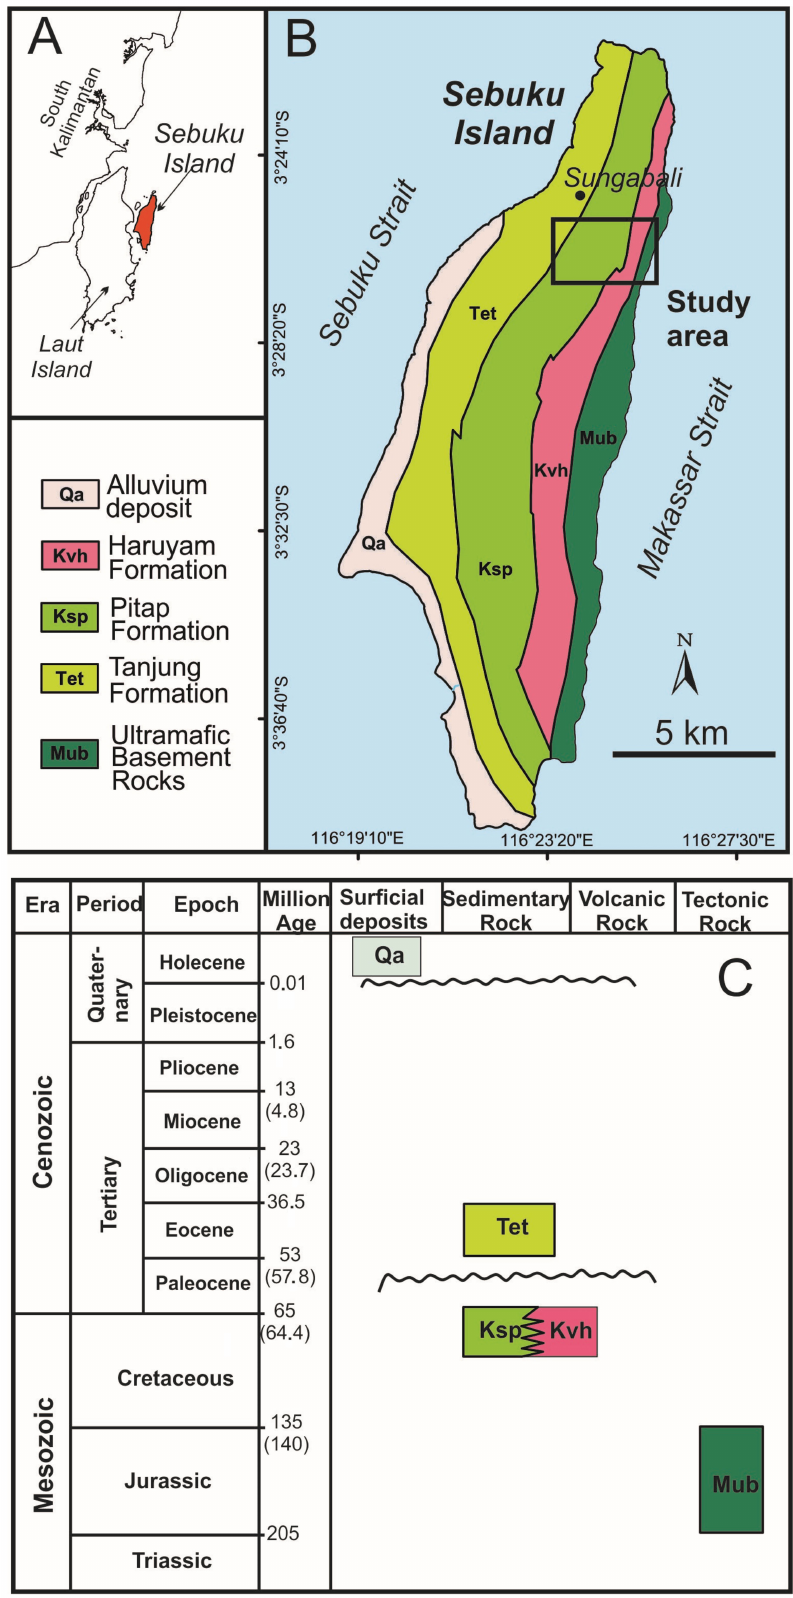
Figure 1. ( A ) Location of Sebuku Island in the SE corner of Borneo (Kalimantan) Island, ( B ) geological map of Sebuku Island (modified from Rustandi et al. [37]) showing the location of the study area and ( C ) regional stratigraphy of Sebuku Island (modified from Rustandi et al.